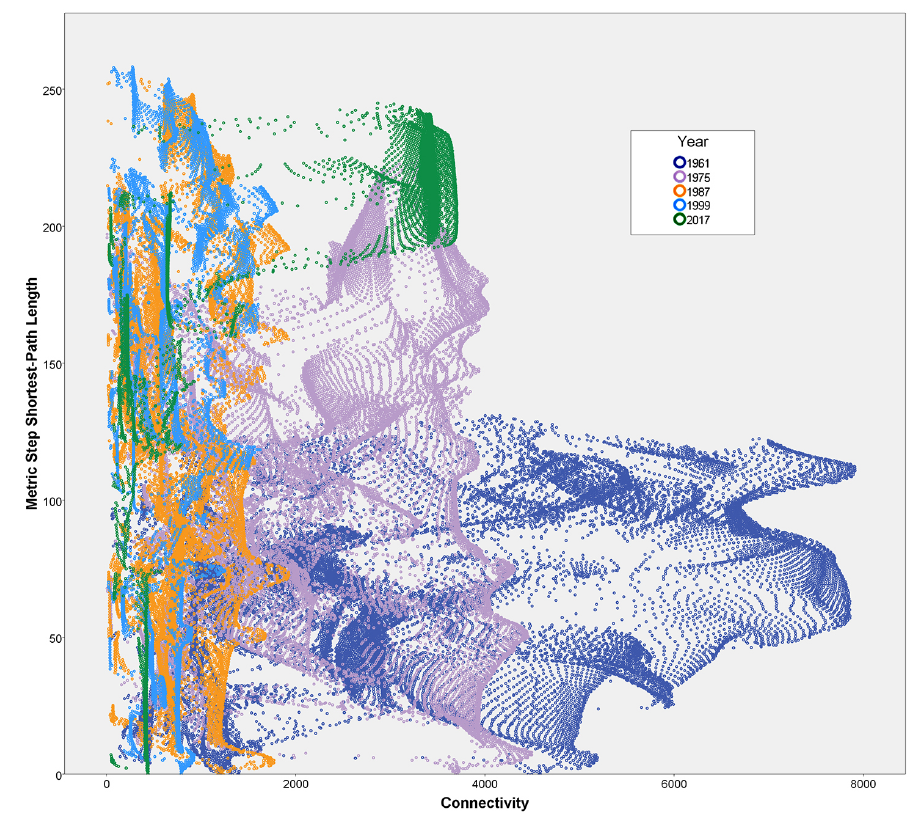
Figure 10. Scatter plot by connectivity and spatial depth of the AMS